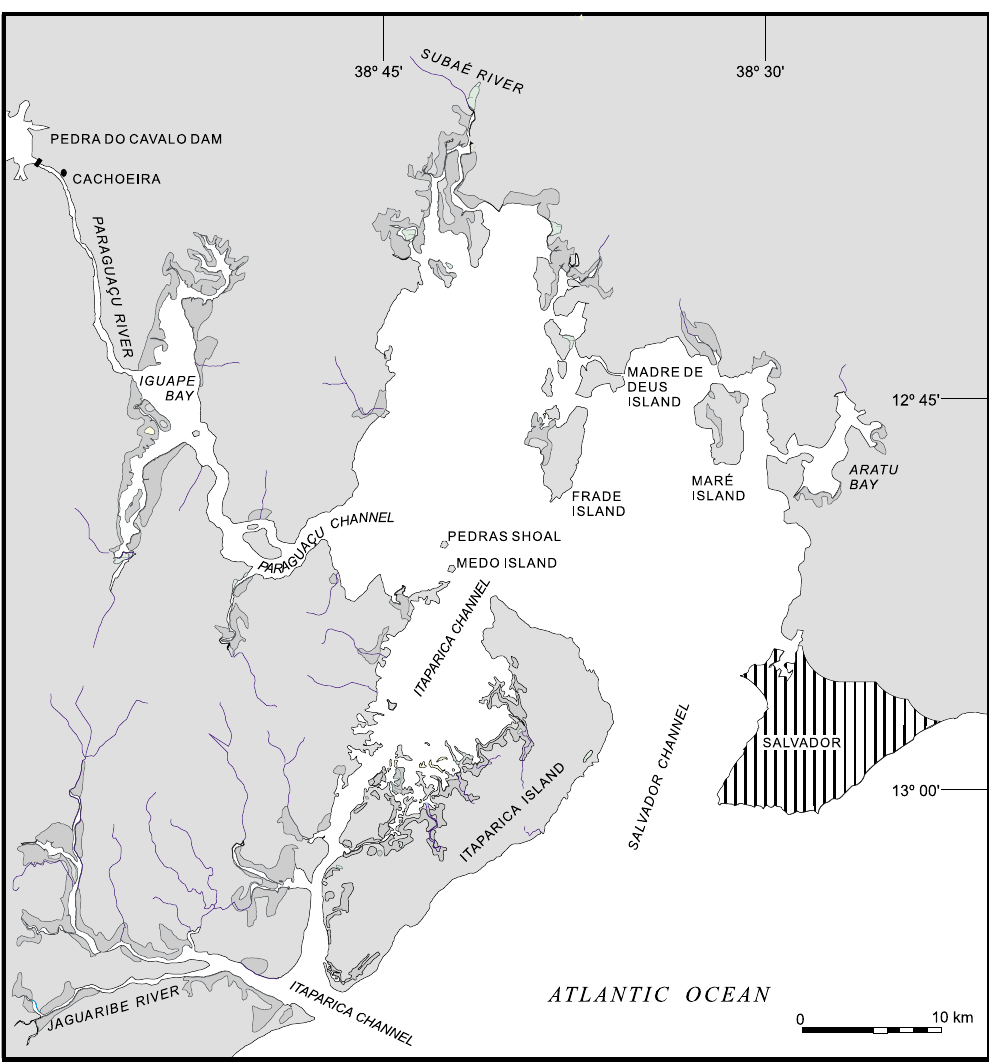
Fig. 1 – Location map of Todos os Santos